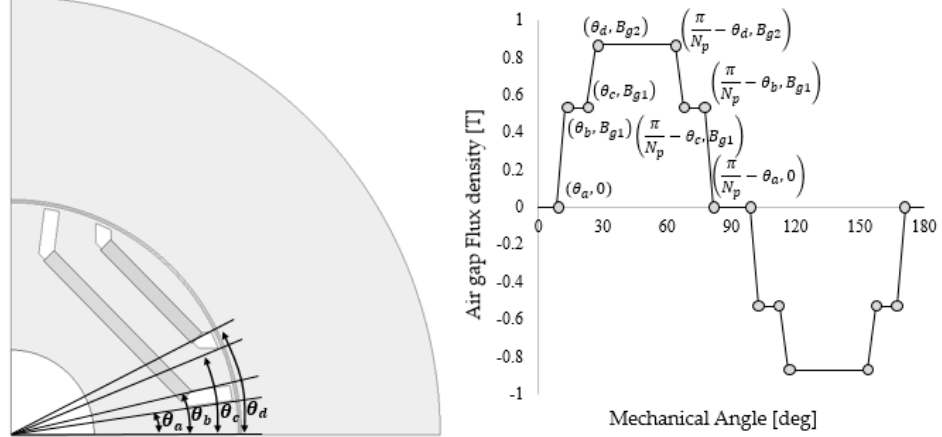
Figure 15. Air gap flux density distribution of a slotless double-layer bar rotor .